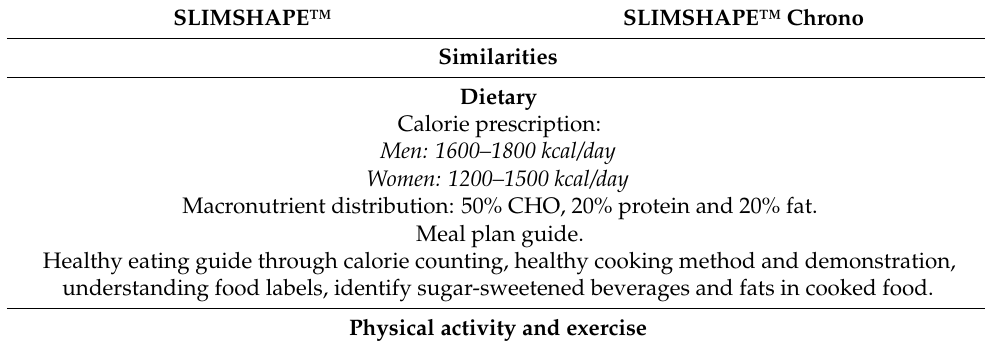
Table 2. Comparison between the previous SLIMSHAPE™ and SLIMSHAPE™